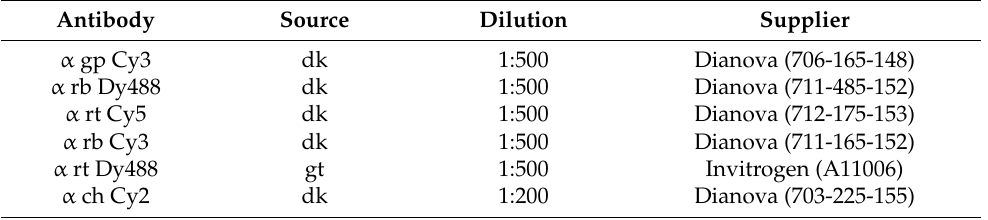
Table 2. Secondary Antibodies Used for Immunocytochemistry. List of Secondary Antibodies Supplied for Immunocytochemistry. Abbreviations: gp, guinea pig; rb, rabbit; rt, rat; ch, chicken; dk,